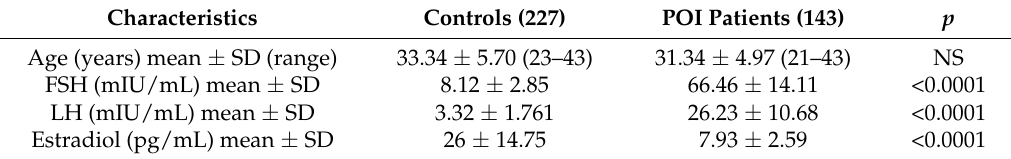
Table 1. Clinical variables of Korean primary ovarian insufficiency (POI) patients and control subjects. Characteristics Controls (227)